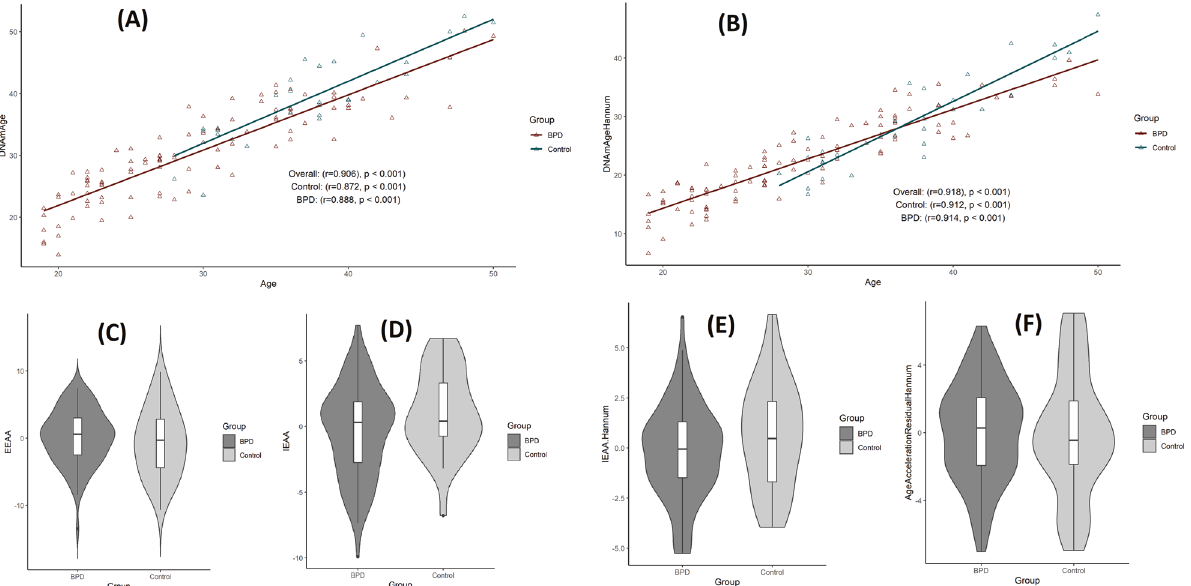
Fig. 1 Horvath and Hannum epigenetic age acceleration. A , B Scatterplots show Horvath or Hannum Age vs chronological age. Pearson ’ s correlation analysis indicated a signi fi cant correlation between DNA methylation age and chronological age in both groups. C – F Violin plot with boxplots show Horvath EAA, IEAA, Hannum EAA, or EEAA. Between-group comparisons were conducted using a Student ’ s t -test. No signi fi cant between group differences were revealed ( p > 0.1). EAA epigenetic age acceleration, IEAA intrinsic epigenetic age acceleration, EEAA extrinsic epigenetic age